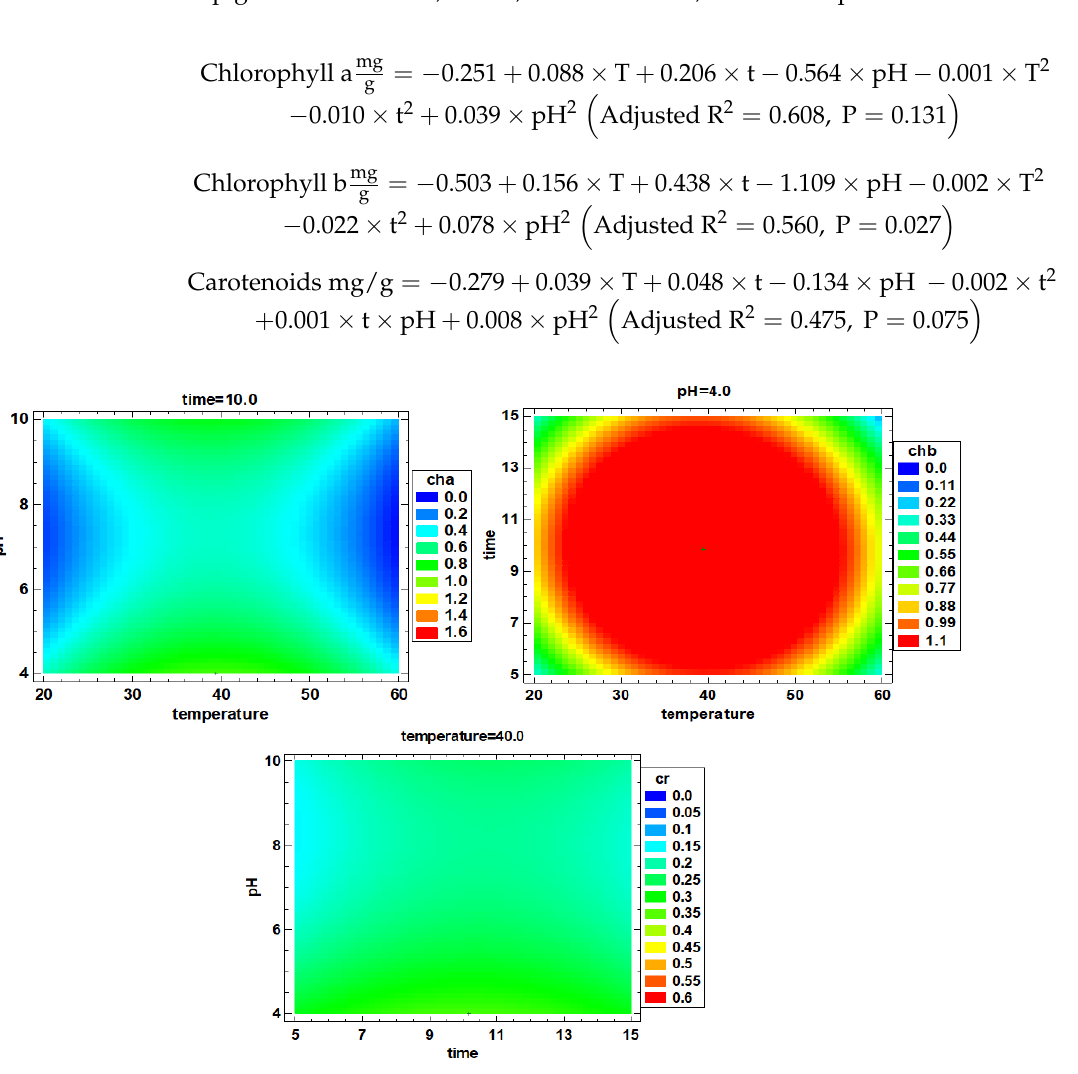
Figure 2. Estimated response surface of chlorophyll a (mg/g), chlorophyll b (mg/g) and carotenoids (mg/g). cha, chb and cr correspond to chlorophyll a, chlorophyll b and carotenoids, respectively.